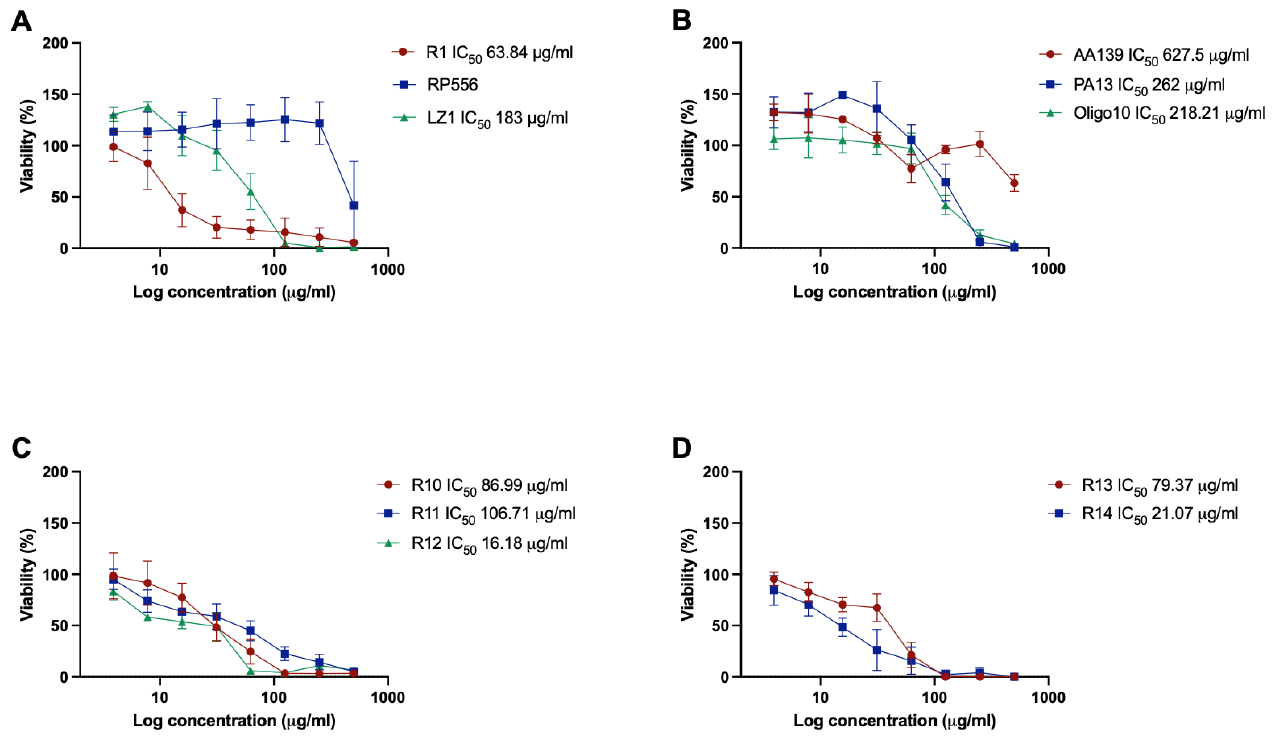
Figure 1. Viability of Balb/c 3T3 cells after incubation with antimicrobial peptides. ( A ) peptides R1, RP556, LZ1, ( B ) peptides AA139, PA13, Oligo10, ( C ) peptides R10, R11, R12, ( D ) peptides R13, R14. Viability expressed as %, compared to control, where applicable IC 50 values are shown, n =